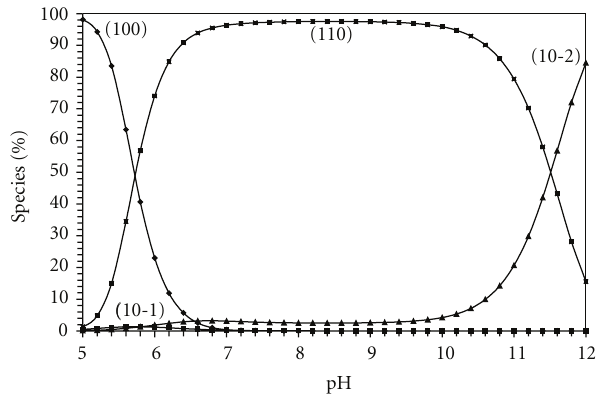
Figure 3: Concentration distribution of various species as a function of pH in the Zn II -BAPP system (1.25mM of Zn 2+ and